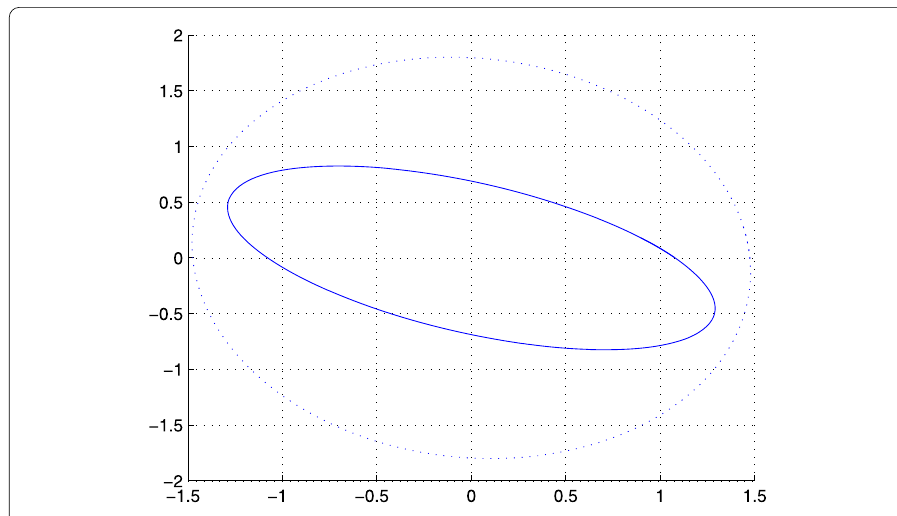
Figure 1 The reachable set estimation for the singular system (1) with φ ( t ) = 0